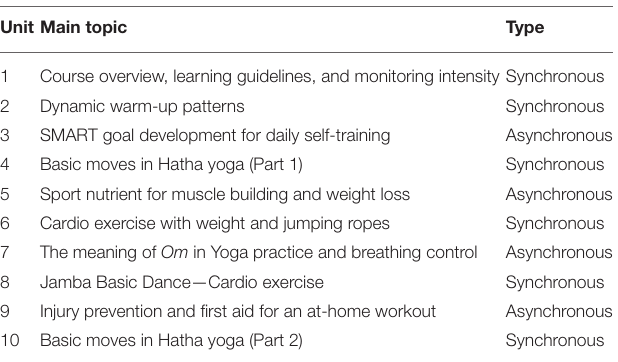
TABLE A1 | Sample course training syllabus—month 1.